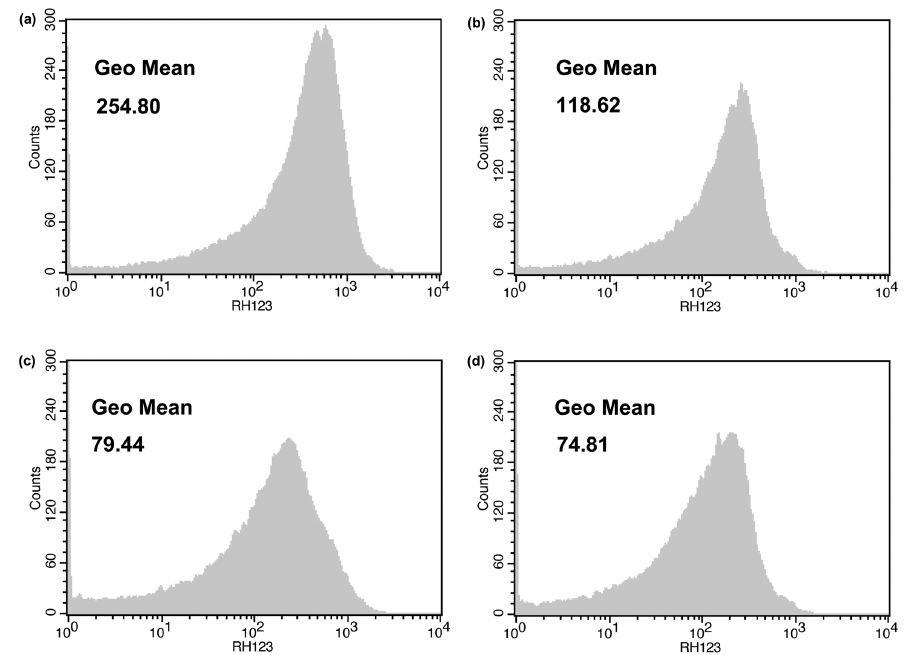
Fig. 5: Effect of bioassay-guided fraction from Athyrium sinense (PA) on membrane potential of Clavibacter michiganensis subsp . sepedonicus (Cms). Cms cells were treated with 0.80% DMSO (control, a); Cms cells were treated with PA at the concentration of 0.05 mg mL -1 (b); Cms cells were treated with PA at the concentration of 0.10 mg mL -1 (c); and Cms cells were treated with PA at the concentration of 0.15 mg mL -1 (d).